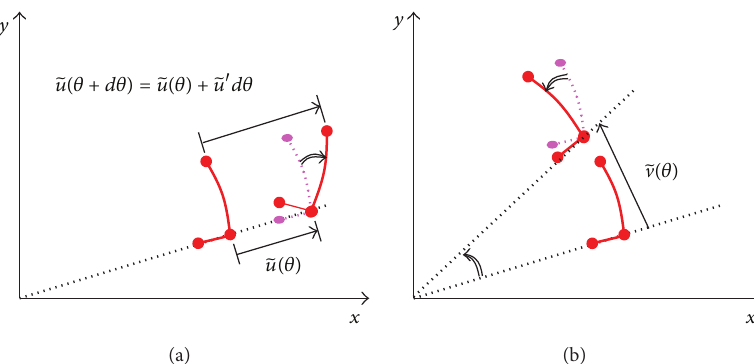
Figure4:Twodifferentmechanismsoftherotationofalineelement.Left:clockwiserotationduetothespatialvariationof ̃𝑢 inthe 𝜃 direction. Right: counterclockwise rotation caused by the circumferential displacement of the